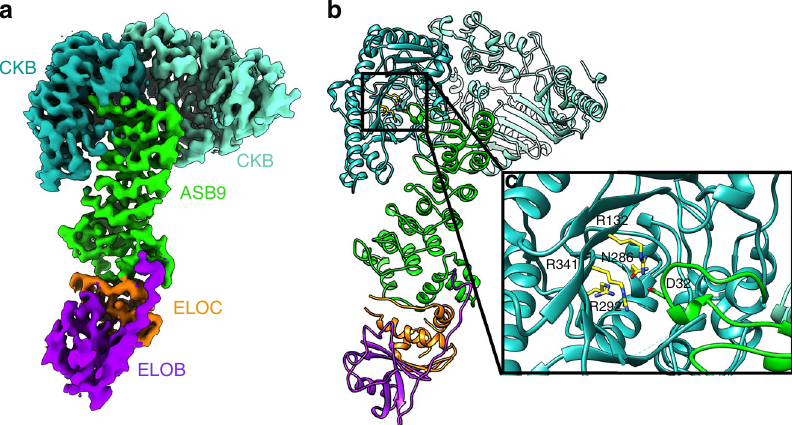
Fig. 1 Structure of the CKB substrate bound to the ASB9 substrate receptor and adapter proteins ELOB/ELOC. a Cryo-EM density of CKB-ASB9-ELOB/ C, colored by subunit, with a fi nal overall resolution of 4.1 Å. b Molecular model for CKB-ASB9-ELOB/C complex. The model was built by fi tting crystal structures (CKB: 3DRB; ASB9/ELOB/C: 3ZKJ), de novo building of small regions using RosettaCM, and overall re fi nement using Rosetta Relax. c The ASB9 N-terminus inserts as one helical turn into the active site of one CKB monomer positioning the ASB9 aspartate D32, which was shown to be critical for high af fi nity binding, in a basic pocket (R132, N286, R292, R341).